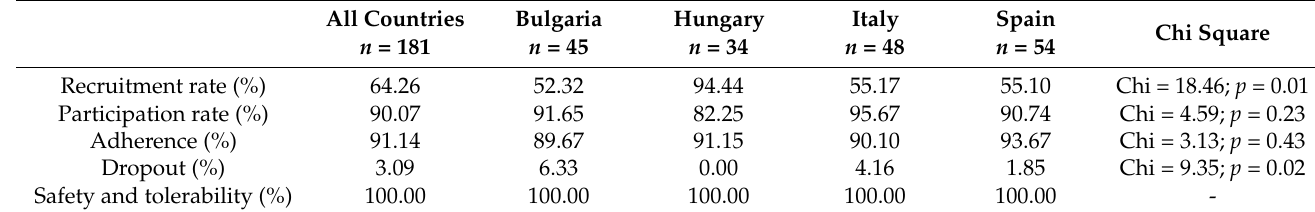
Table 2. Feasibility of STRENOLD program.